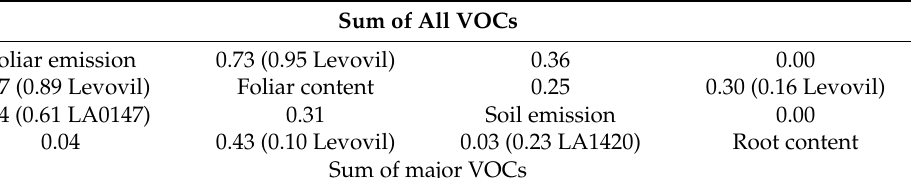
Table 3. Coefficients of determination (R 2 ) of Pearson correlation analyses between foliar VOC emissions, foliar VOC contents, soil VOC emissions, and root VOC contents of the 8 tomato genotypes based on the mean values of three to six replicate measurements per genotype. Correlations with R 2 ≥ 0.3 are considered as meaningful. If correlations between genotypes were obviously biased by a single outlier, R 2 without outlier are given in parenthesis, together with the name of the genotype outlier (see also Figure 3).